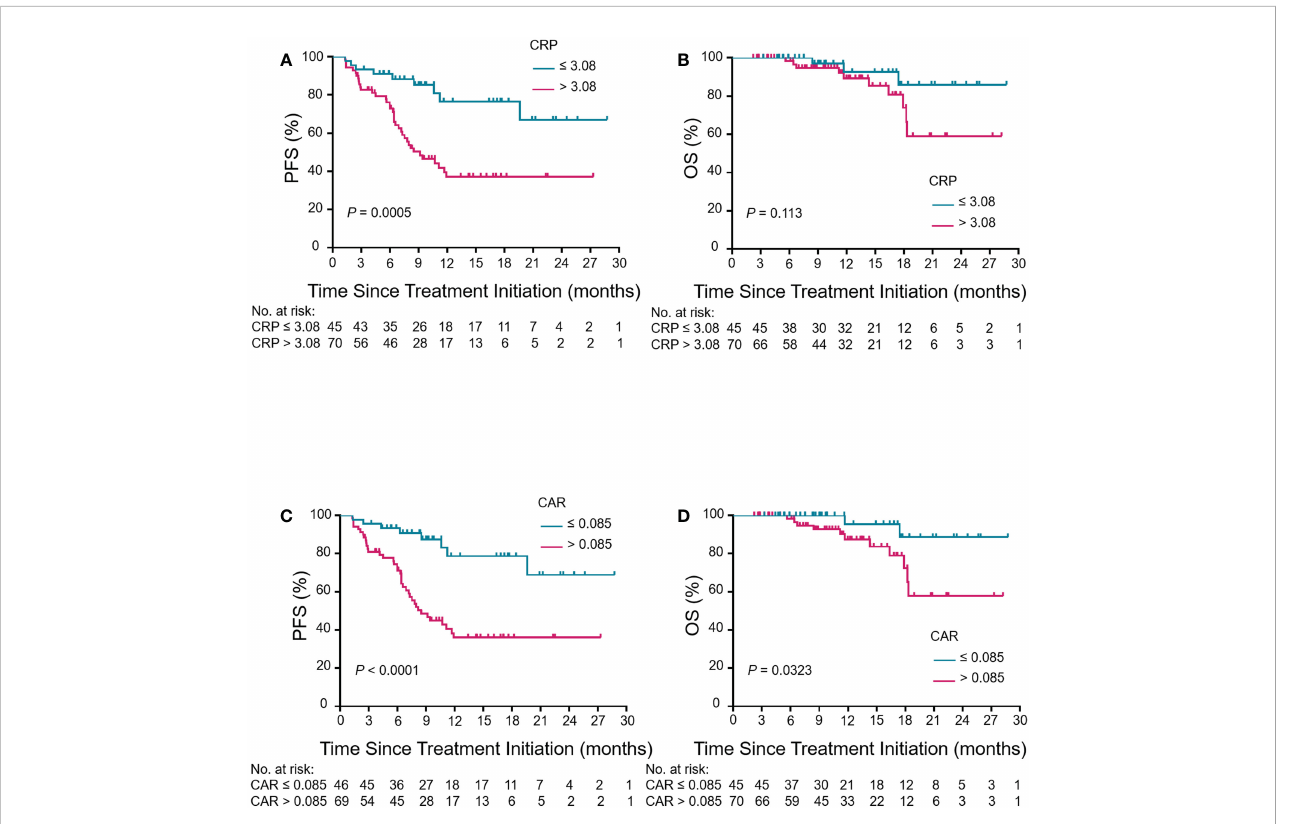
FIGURE 5 Association between pretreatment CRP and CAR levels and clinical outcomes in patients with R/M CC who underwent tislelizumab treatment. Kaplan – Meier curves of PFS and OS for CRP (A, B) and CAR (C, D) in the enrolled population. Kaplan – Meier analysis and log-rank tests were used for comparison between low-level group (blue group) and high-level group (red group) of CRP and CAR in PFS and OS. CRP, C-reactive protein; CAR, CRP-to-albumin ratio; PFS, progression-free survival; OS, overall survival; R/M CC, recurrent or metastatic cervical